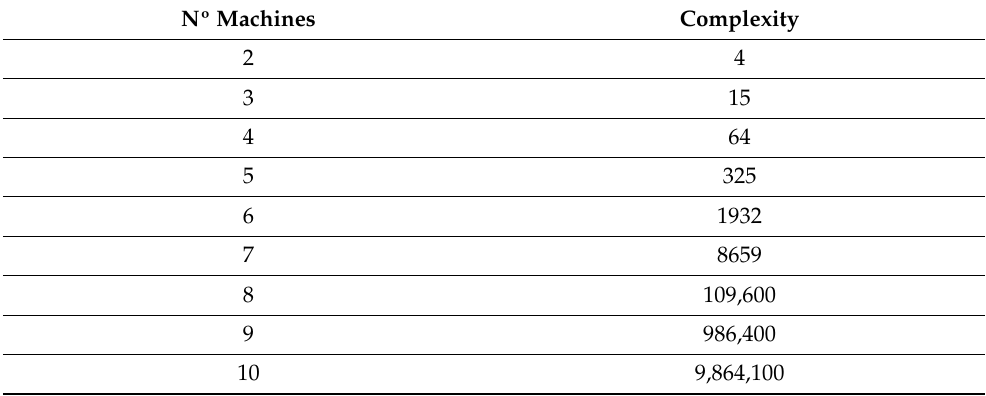
Table 1. Problem